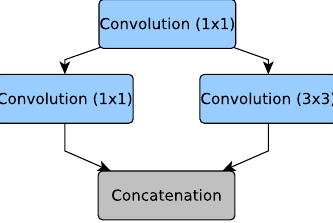
Figure 1. Architecture of a Fire module. A so-called squeeze operation is performed by the 1x1 convolutional layer. Subse- quently an expand operation that is a combination of 1x1 and 3x3 filters increases the number of activation maps while keeping the number of parameters